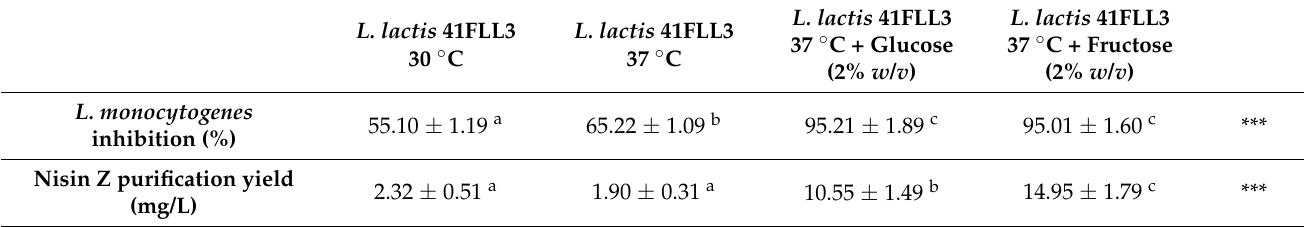
Table 2. Percentage of L. monocytogenes inhibition by purified Nisin Z produced by L. lactis 41FLL3 grown at two different temperatures (30 and 37 ◦ C) and with two different carbon sources (glucose and fructose) and Nisin Z purification yields (mg/L). Data represent means ± standard deviations (N = 3). Statistics: ANOVA p < 0.001 (***). Tukey’s post hoc tests were performed and letters indicate significant differences between